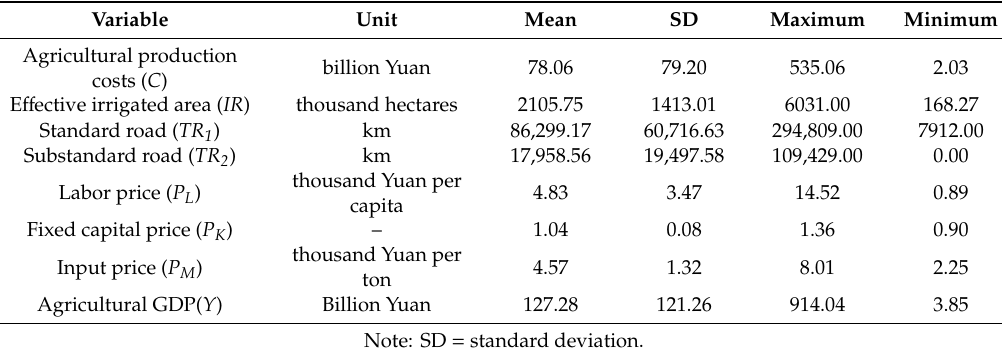
Table 1. Descriptive statistics of each variable.